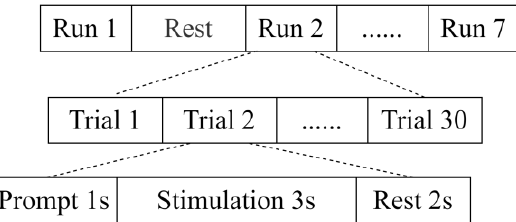
Figure 3. Extended experiment timing diagram.